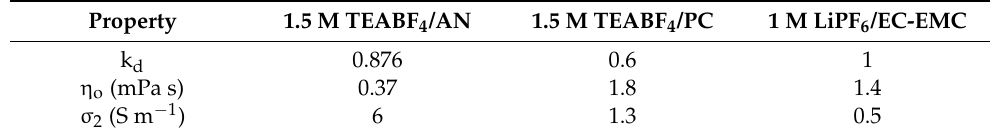
Table 1. Properties of the electrolyte systems used in this study [53,58–61].